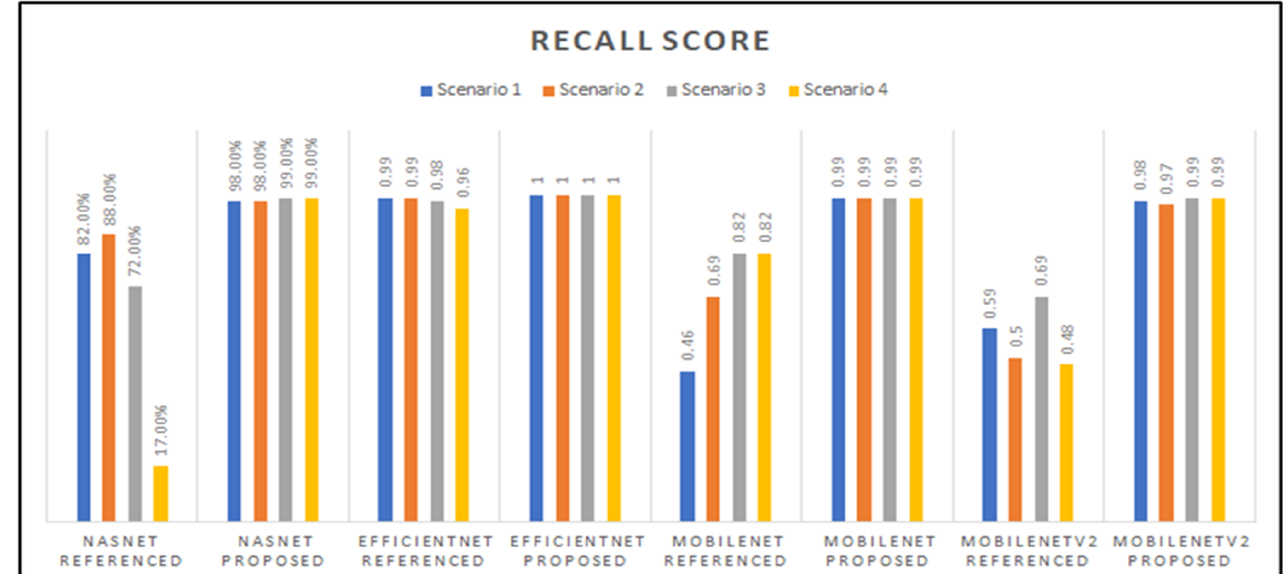
Figure 14. Graphed results of recall scores for all models developed.